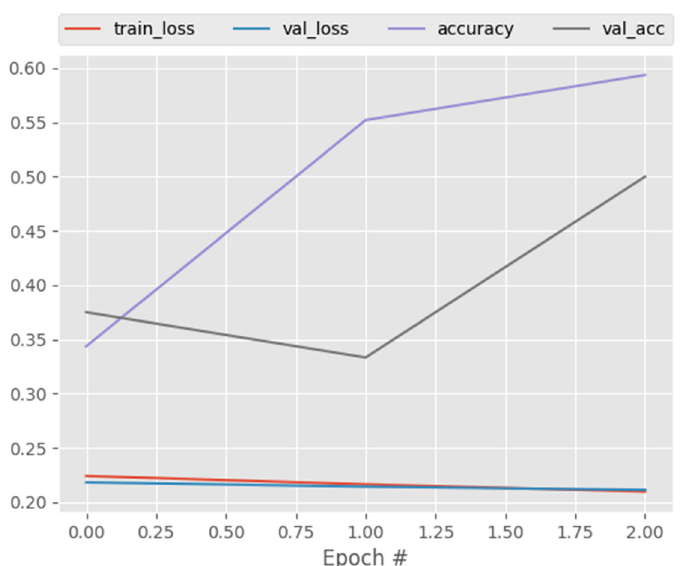
Figure 14. CNN training and validation performance for X-ray images.